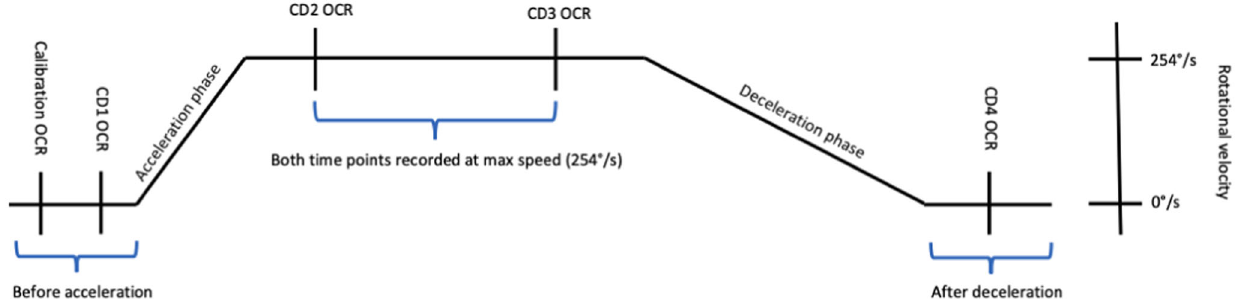
Fig. 4 Visual overview of conducted measurements. Before acceleration, at a standstill, the calibration and the fi rst OCR measurement (CD1) were performed. After an acceleration phase of 30°/s, when the maximal rotational velocity of 254°/s was reached during rotation, the second and third measurements of the OCR (CD2 and CD3) were performed. After the cessation of a 3°/s deceleration phase, at standstill, the last OCR measurement was performed (CD4).